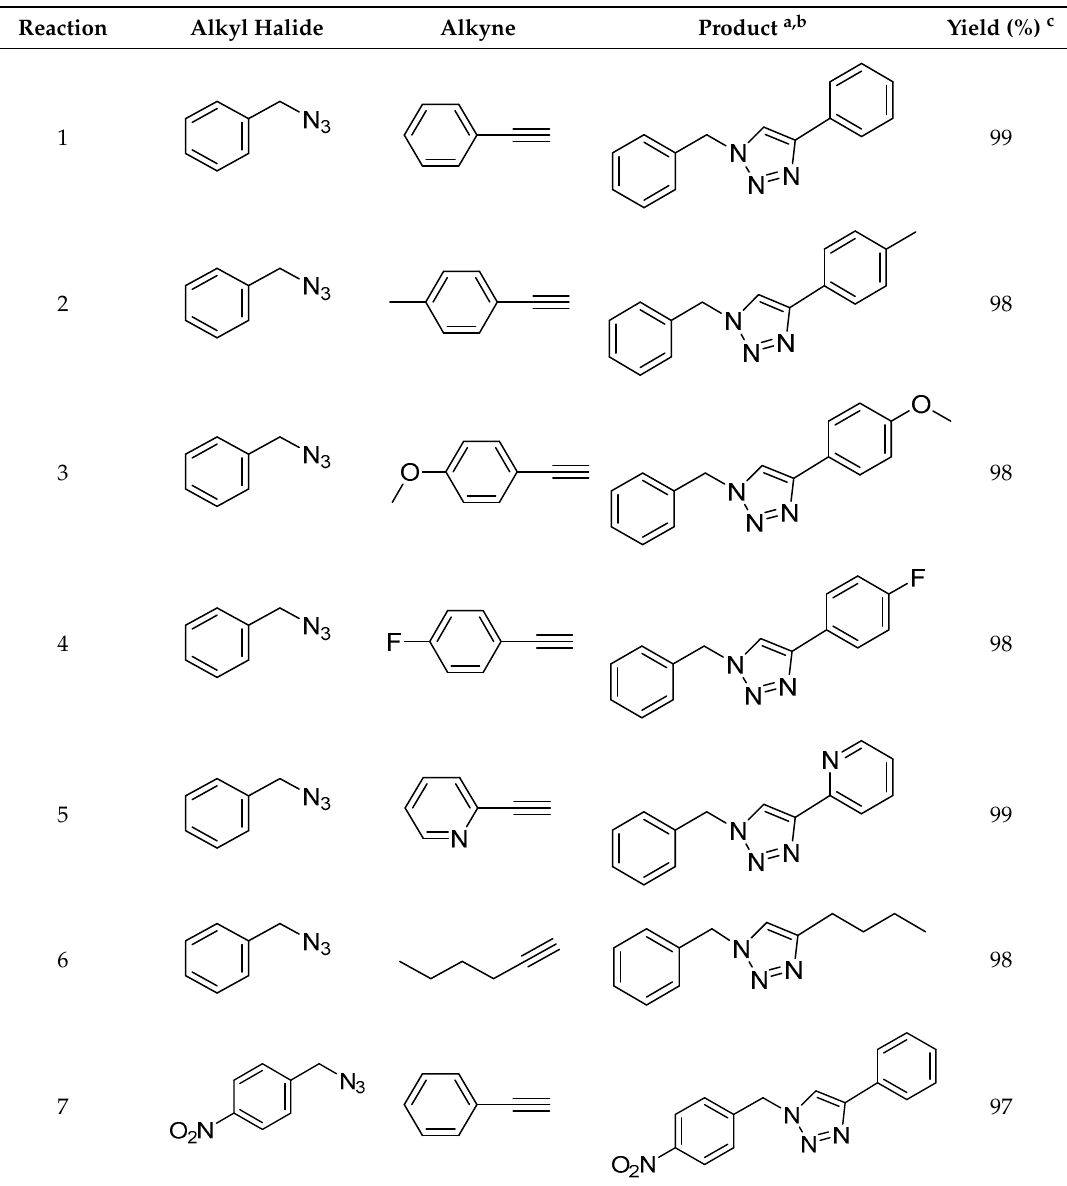
Table 1. Huisgen “click” reactions using Cu 2 O@L.